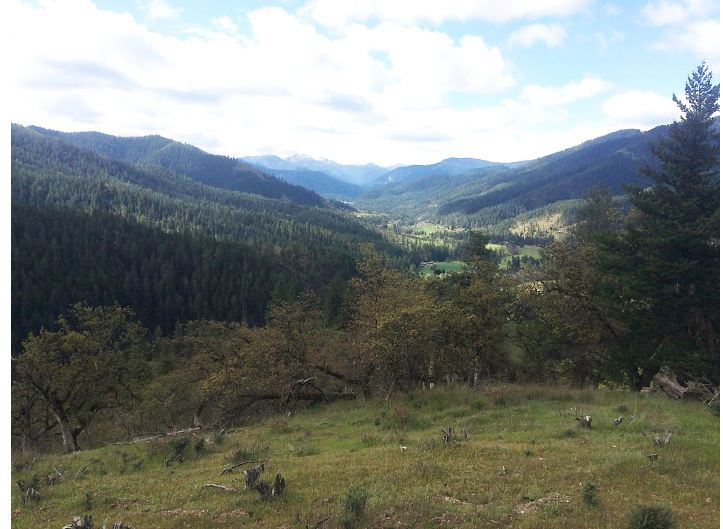
Figure 2. View of the Applegate Adaptive Management Area. Planned project activities for this area were evaluated based on projected climate change impacts in southwestern Oregon. Photo by D. Boucher, U.S. Forest